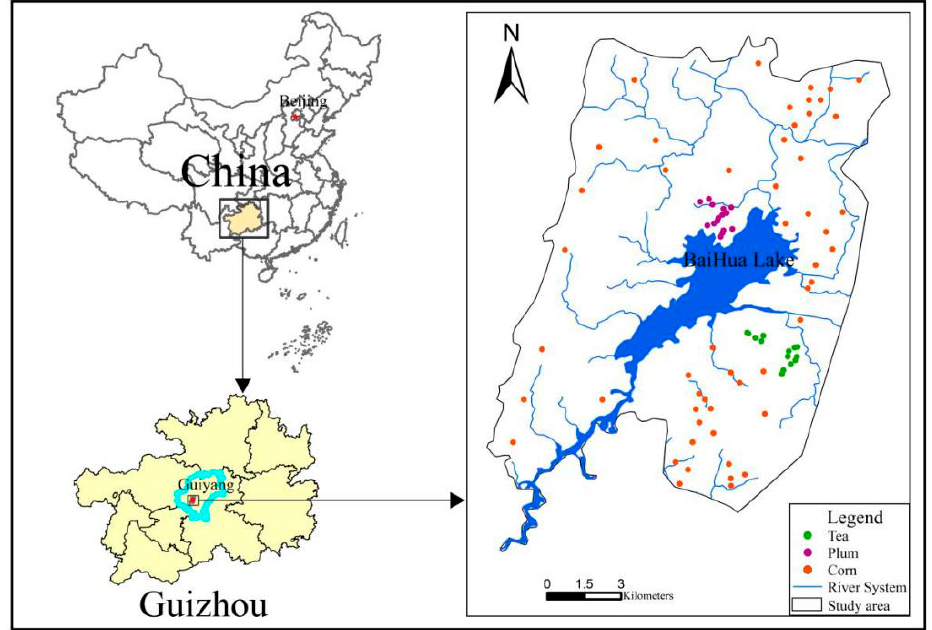
Figure 1. Map of the study area and sampling sites in the BH